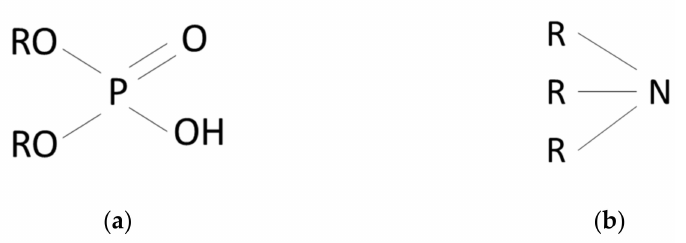
Figure 1. Chemical structure of ( a ) phosphonic acid and ( b ) amine-based extractants used in solvent extraction step for Co